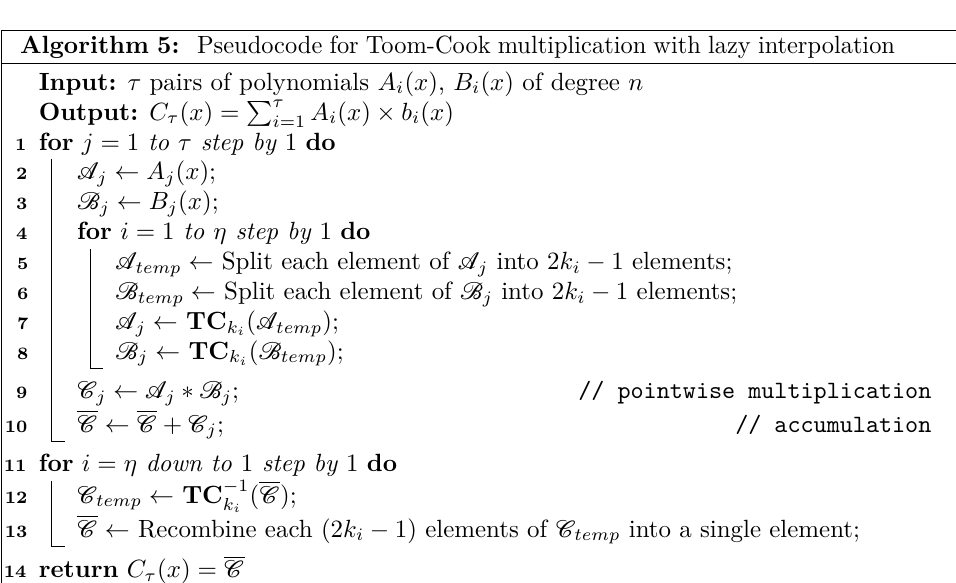
A i ( x ) × B i ( x ) using lazy interpolation . i =1